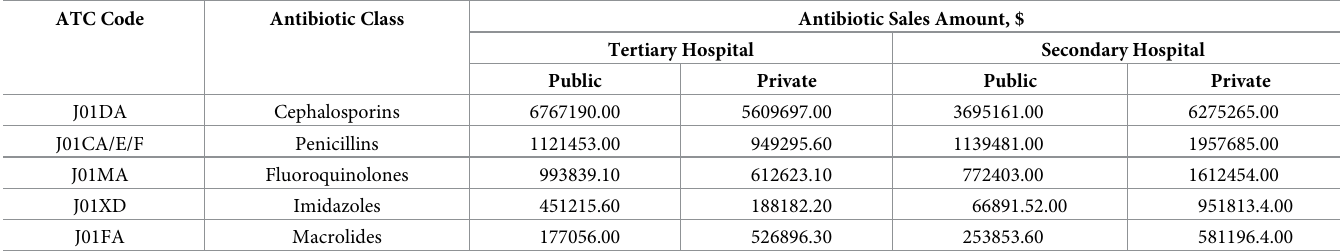
Table 3. Highest amount of antibiotic classes used in